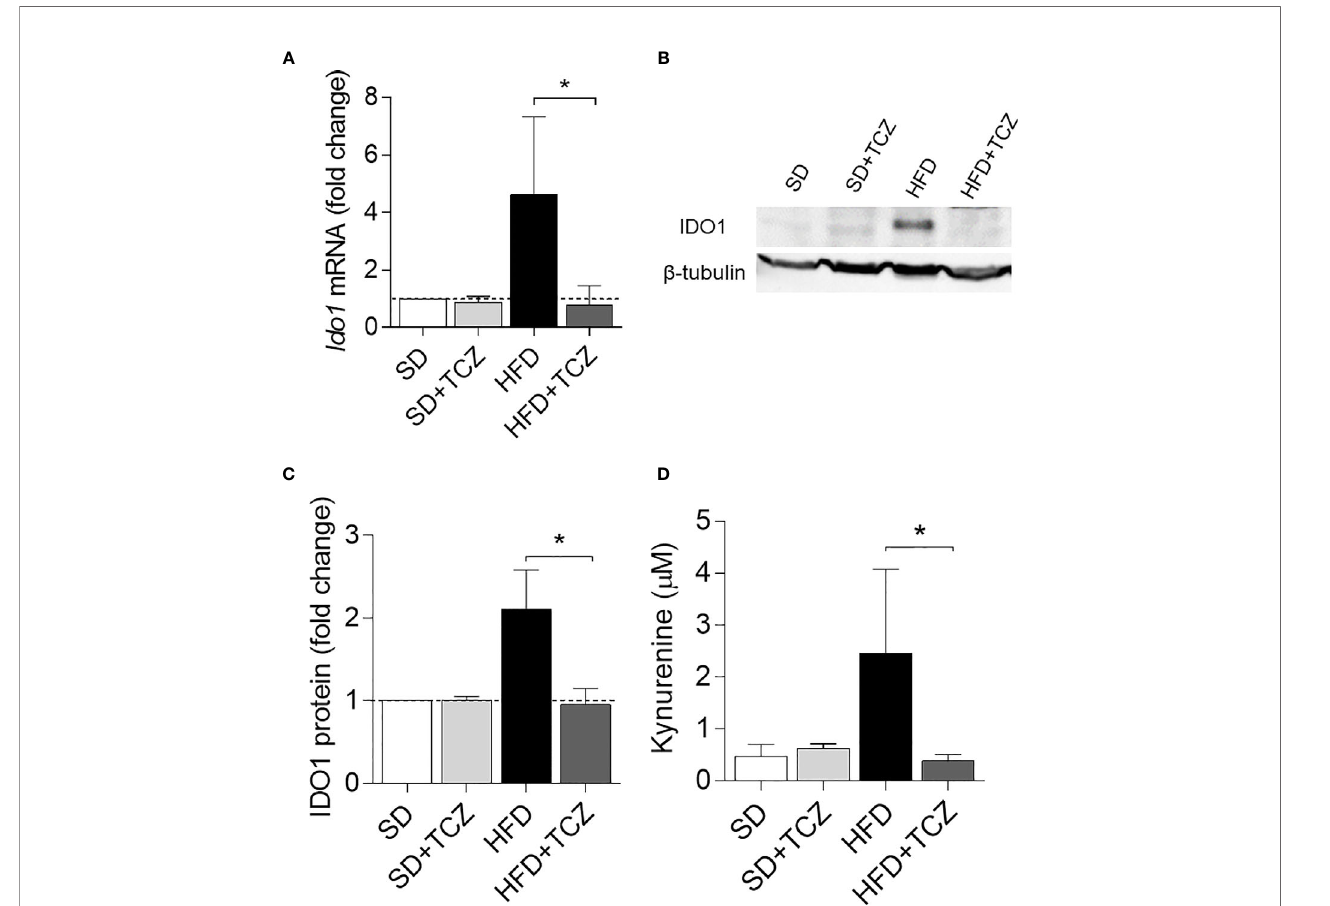
FIGURE 3 | TCZ inhibits IDO1 expression in SVF WAT. (A) Gene transcription of Ido1 in SVF WAT cells after 9 wk of diet. Data (mean ± S.D., n = 3 biological replicates, from two independent experiments) represent the fold change expression of Gapdh -normalized transcripts in which the calibrator is represented by SVF WAT from SD-fed mice (fold change = 1; dotted line). (B) IDO1 protein expression in SVF WAT cells and quantitative analysis (C) of immunoblots from two independent ex vivo experiments, one of which shown in (B) . Data (mean ± S.D., n = 3 biological replicates, from two independent experiments) represent the ratio of tubulin-normalized IDO1 protein expression in SVF cells from HFD-fed mice to that expressed in SVF from animals on SD (n=3 mice per group). (D) Levels of Kyn (mean ± S.D., n = 3 biological replicates, from two independent experiments) secreted by SVF WAT cells in 24 − h culture supernatants. *p < 0.05 (ANOVA followed by post hoc Bonferroni ’ s method for A, C, D